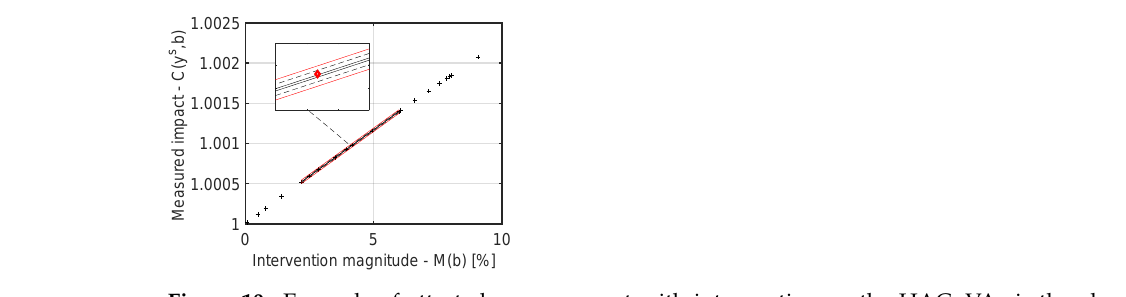
Figure 10. Example of attested measurement with intervention on the HAC. VAc is the observ- able variable.